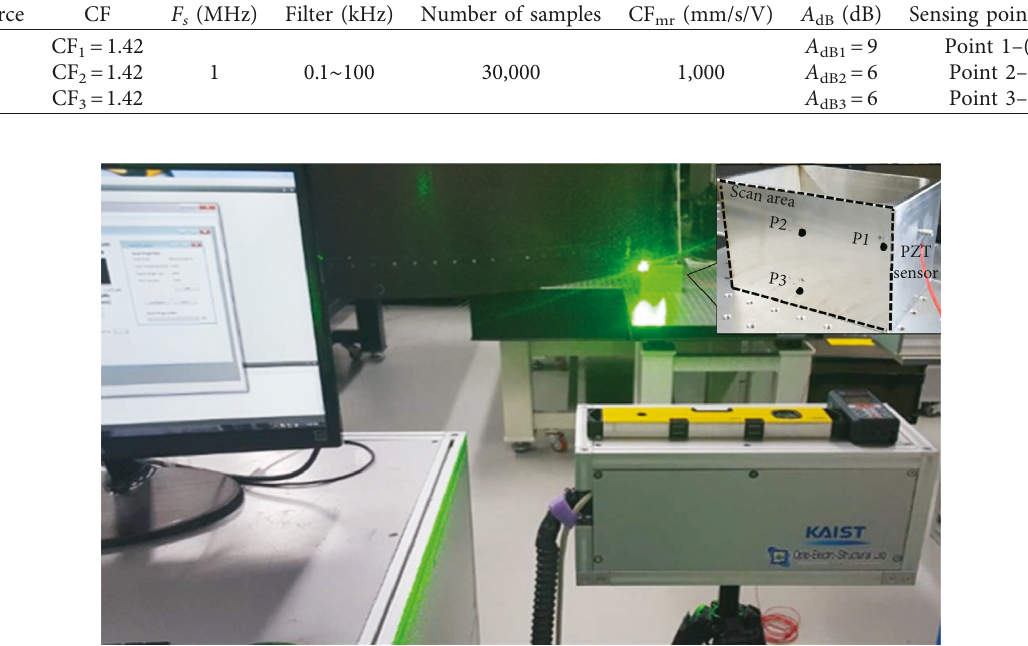
Figure 4: Laser scanning measurement setup for simulation of pyroshock on the open-box-type tension